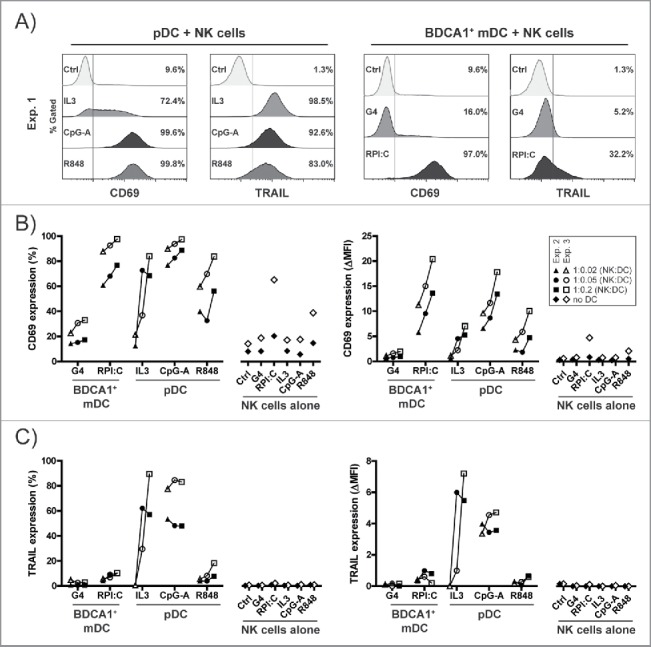
HSPC-pDCs superiorly induce activation of cytolytic NK cells. HSPC-DCs were generated as described in Fig. 1, and subsequently BDCA1+ mDCs were sorted from G4 culture and pDCs from FST culture. Next, the different HSPC-DCs were seeded and medium was added containing respective TLR-ligands and cytokines as indicated in the figure. Without washing, allogeneic NK cells were added to the DCs at 1:0.2, 1:0.05 or 1:0.02 ratio (NK:DC). As control, NK cells were cultured without DCs in the absence (control = ctrl) or presence of the different DC maturation cocktails. By flow cytometry, expression of CD69 and TRAIL on NK cells was determined after 40 h co-culture. (A) Histograms depicting expression of CD69 and TRAIL on DC-primed NK cells of experiment 1 at a NK:DC ratio of 1:0.2. (B–C) The percentage and mean fluorescent intensity (MFI) of CD69 (B) and TRAIL (C) on NK cells of experiments 2 and 3 at a NK:DC ratio of 1:0.2, 1:0.05 or 1:0.02. (A–C) Data shown are from three independent experiments using three different HSPC-DC and three different NK cell donors. NK cell purity was 97%, 87% and 97% for experiments 1, 2 and 3, respectively. Exp. = Experiment.